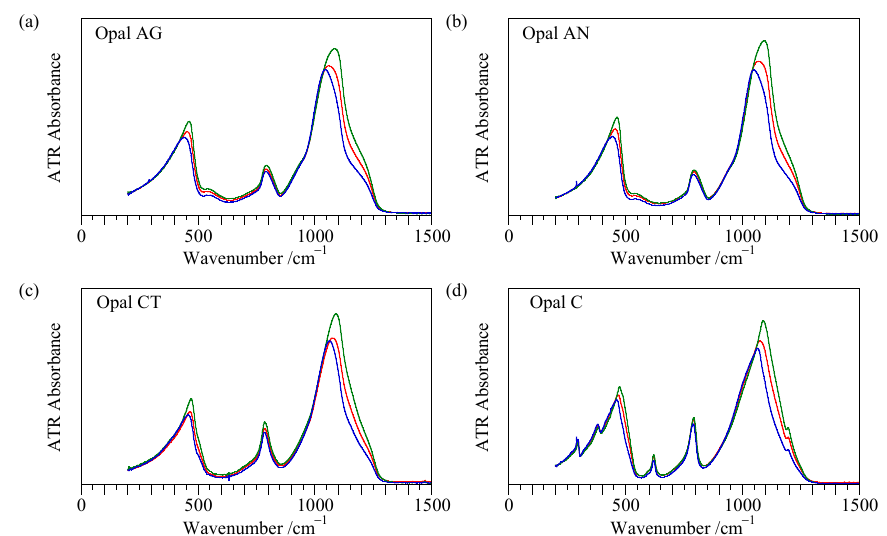
Figure 12. ATR spectra of the most finely ground samples showing the effect of polarisation on ( a ) opal-AG (G NEW22 from Lambina, South Australia, Australia), ( b ) opal-AN (G8877 from Squaretop, Dalby, Queensland, Australia), ( c ) opal-CT (G9942 from Angaston, South Australia, Australia) and ( d ) opal-C (T1664 from Guanajuanto, Mexico). Spectra are depth corrected but not otherwise manipulated. Red is unpolarised, green is p -polarised and blue is s -polarised.